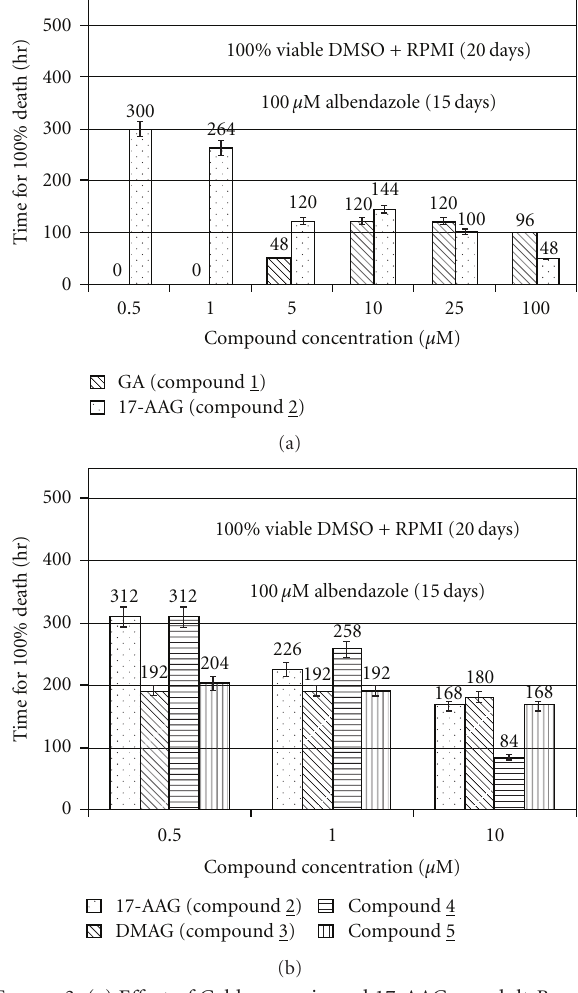
Figure 3: (a) E ff ect of Geldanamycin and 17-AAG on adult Brugia malayi in vitro. 17-AAG killed B. malayi adults faster and at concentrations two hundred times lower than albendazole (positive control). Statistically significant di ff erences in rates of killing were observed for 5–100 µ M GA and 17-AAG versus 100 µ M albendazole (positive control, P < . 001). 500nM and 1000nM GA and 17- AAG were equivalent to 100 µ M albendazole at 280–300 hours. (b) E ff ect of 17-AAG compared to three other GA derivatives on adult B. malayi in vitro . Negative control worms (i.e., no drug) remain viable for 500 hours and 100 µ M albendazole kills parasites by 15 days. All three concentrations of the four GA derivatives killed adult B. malayi faster than 100 µ M albendazole (positive control, P < . 001). Numbers above each bar are mean hours to 100% killing. Compounds 3 (DMAG) and 5 (5 (cid:2) -bromogeldanoxazinone) were more active against B. malayi than 17-AAG at 500nM ( P < . 001). All four compounds at each concentration tested (500nM—10 µ M) killed filarial more quickly than 100 µ M albendazole (positive control, P < . 001). For (a) and (b), the data represent the mean